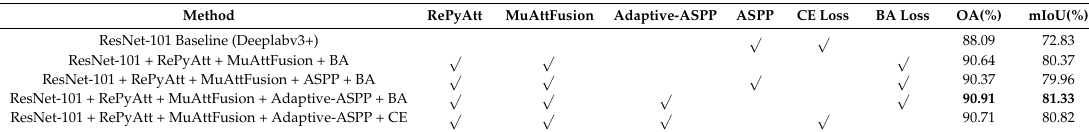
Table 4. Results of the ablation study on the Vaihingen testing dataset; the values in bold are the best. All results are the average of three runs with maximum epoch = 10 and mini-batch size = 4.